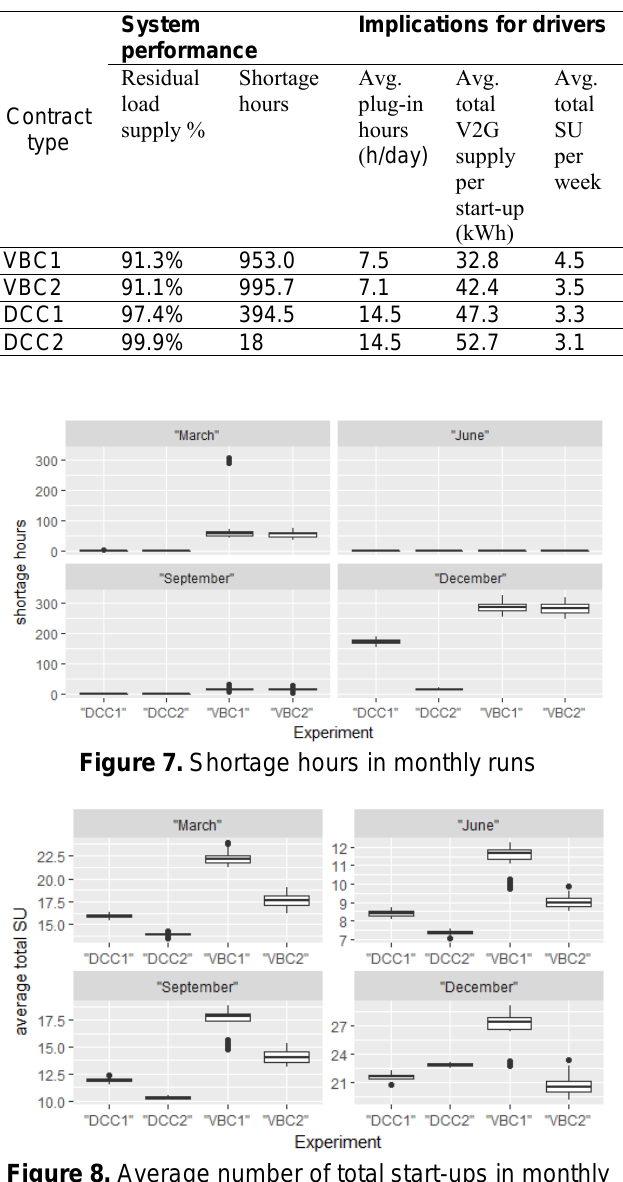
Figure 8. Average number of total start-ups in monthly